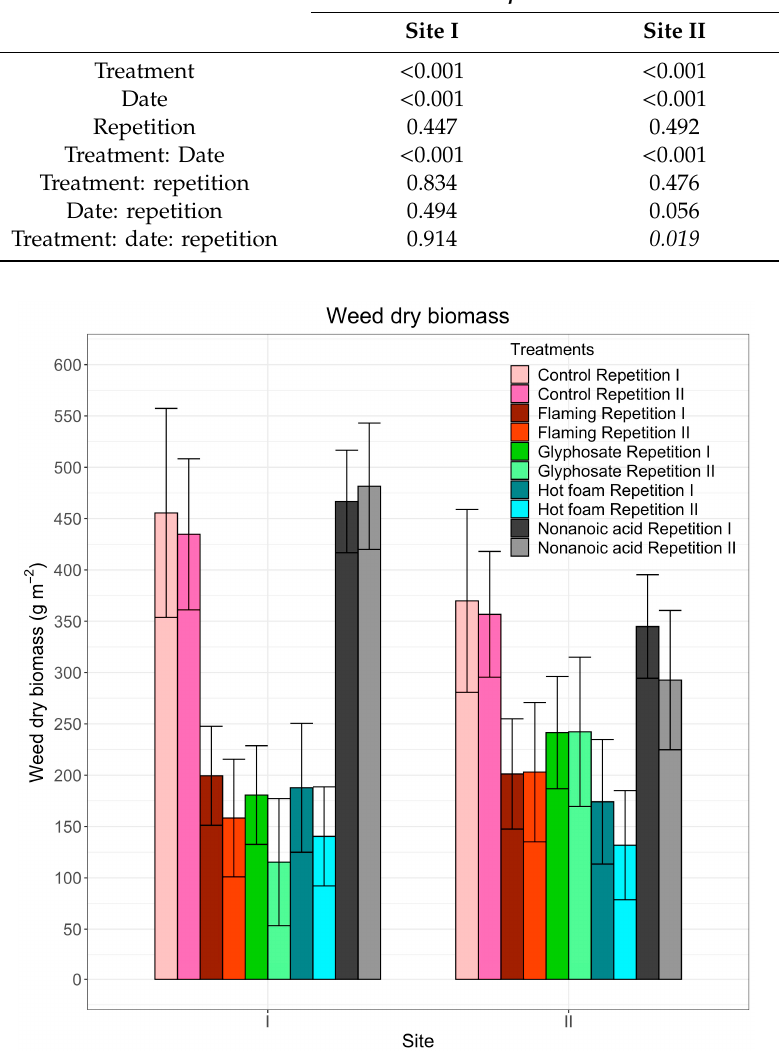
Figure 4. Weed dry biomass bar graph and 95% confidence interval as affected by the treatments (control, flaming, glyphosate, hot foam and nonanoic acid), repetition and evaluation date at sites I and II, respectively.